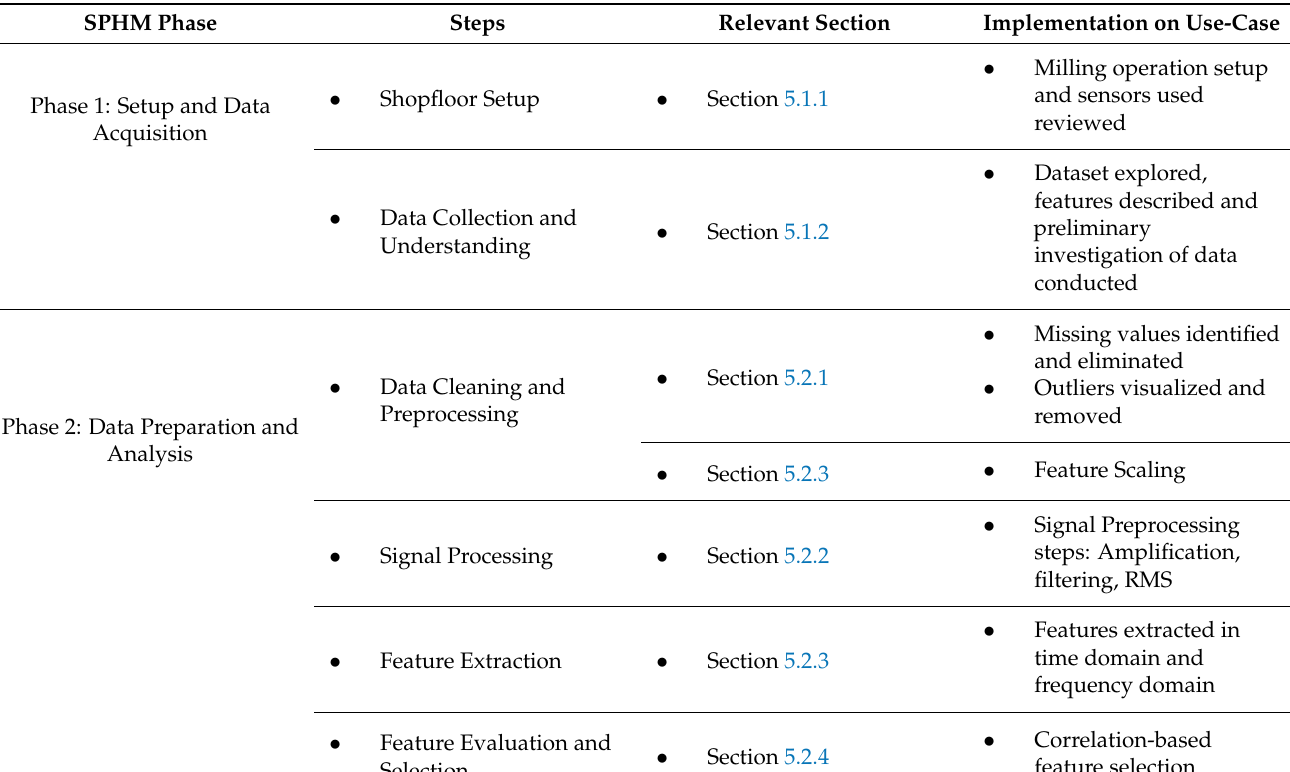
Table 5. SPHM Phases implemented on milling